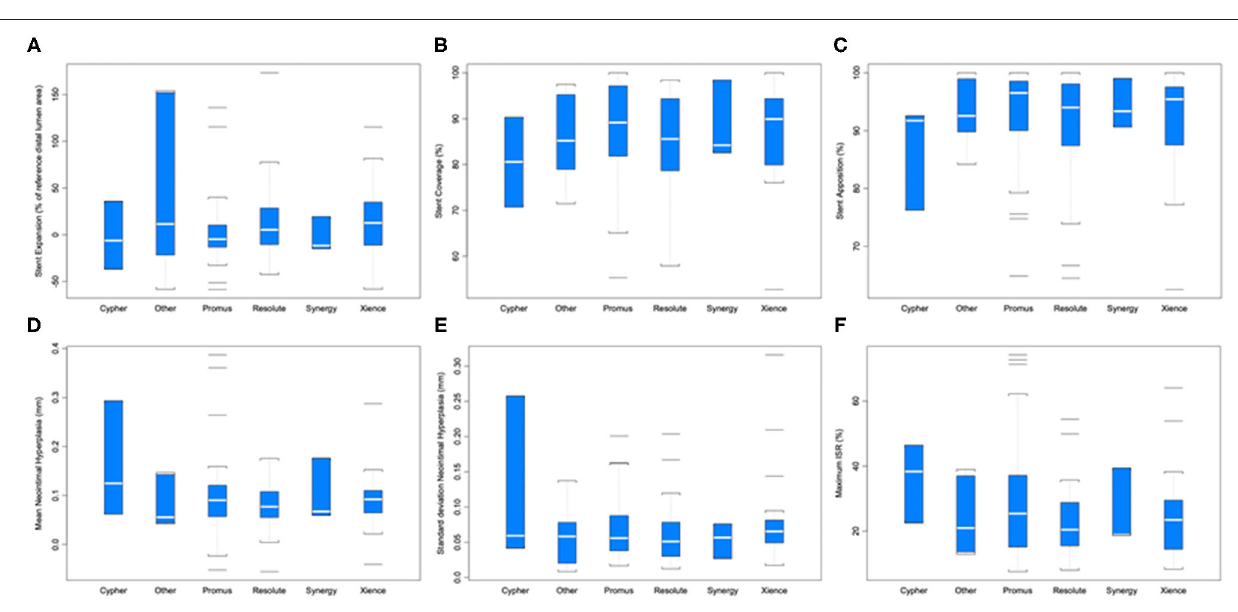
FIGURE 4 | Stent healing parameters by different stent brands. (A) Stent expansion ( P = 0.502). (B) Stent coverage ( P = 0.707). (C) Stent apposition ( P = 0.210). (D) Mean neointimal hyperplasia (mm) ( P = 0.736). (E) Standard deviation of neointimal hyperplasia ( P = 0.591). (F) Maximum in-stent restenosis (ISR; P =